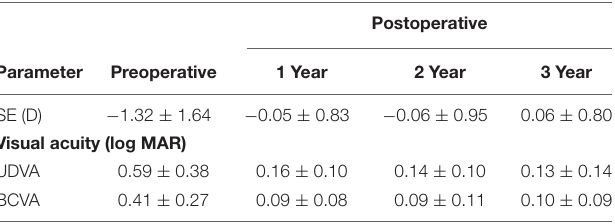
TABLE 3 | Visual acuity and refractive outcomes of all patients.